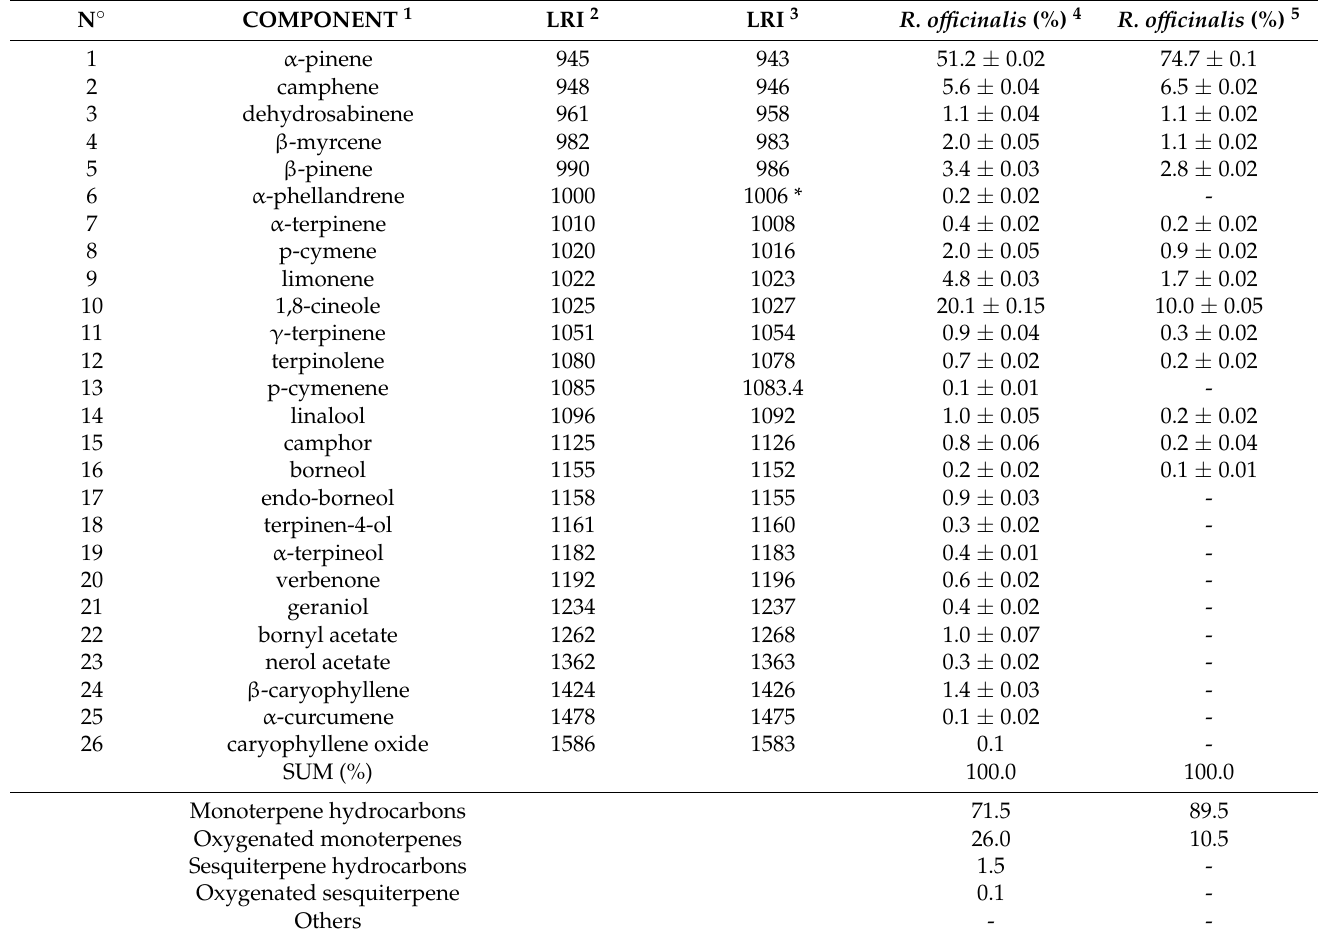
Table 1. Chemical composition (%) of liquid and vapor phase R. officinalis essential oil